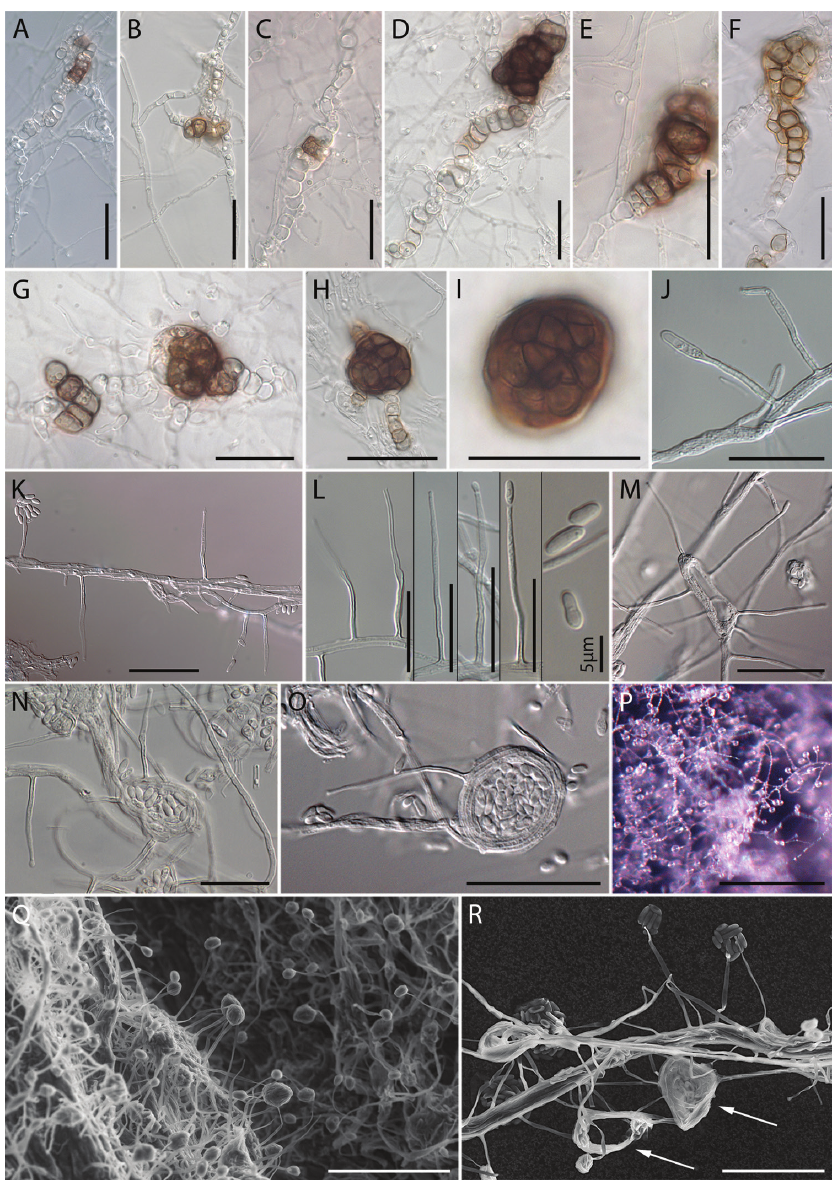
Figure 3. Micrographs of Monocillium gamsii . A–C Hyphal growth by intercalary development of chla- mydospore and dityochlamydospore-like structures filled with guttules D–H initiation of microsclerotia by interweaving or coiling of dictyochlamydospores, and growth to full size I Highly pigmented sclerotium at maturity displaying a textura angularis on surface view J–N Setae, phialides and conidia M–O Formation of phialides on coiling hyphae P Conidial heads, conidia cohering in wet heads Q, R SEM: Q Phialides from mycelium with conidial heads, arising from hyphae R coiling hyphae (arrows), and detail of phialides bearing conidia A–I from PDA 1/3 strength J–P from PDA; Q, R from OA. Scale bars: 30 µm ( A, H, I, K, M, O, R ); 20 µm ( B–G, J, L, N ); 200 µm ( P ), 50 µm ( Q